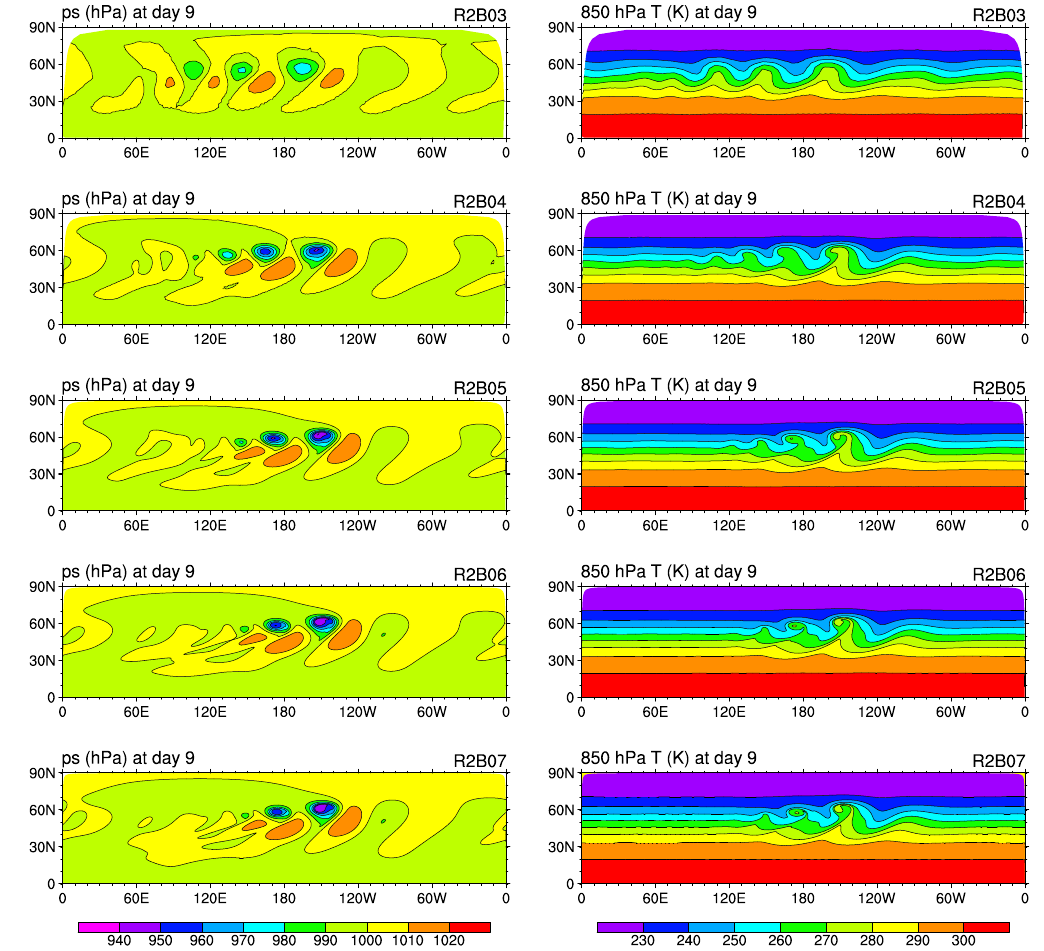
Fig. 7. Surface pressure (unit: hPa, left column) and 850hPa temperature (unit: K, right column) at day 9 in the Jablonowski and Williamson (2006a,b) baroclinic wave test simulated by the new dynamical core at various horizontal resolutions. Further details can be found in Sect.